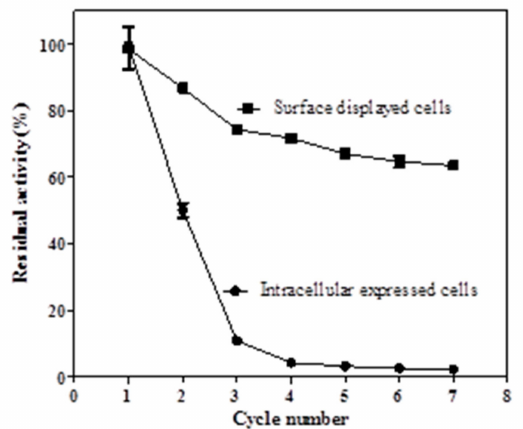
Figure 7. Reusability of the surface-displayed and intracellular expressed